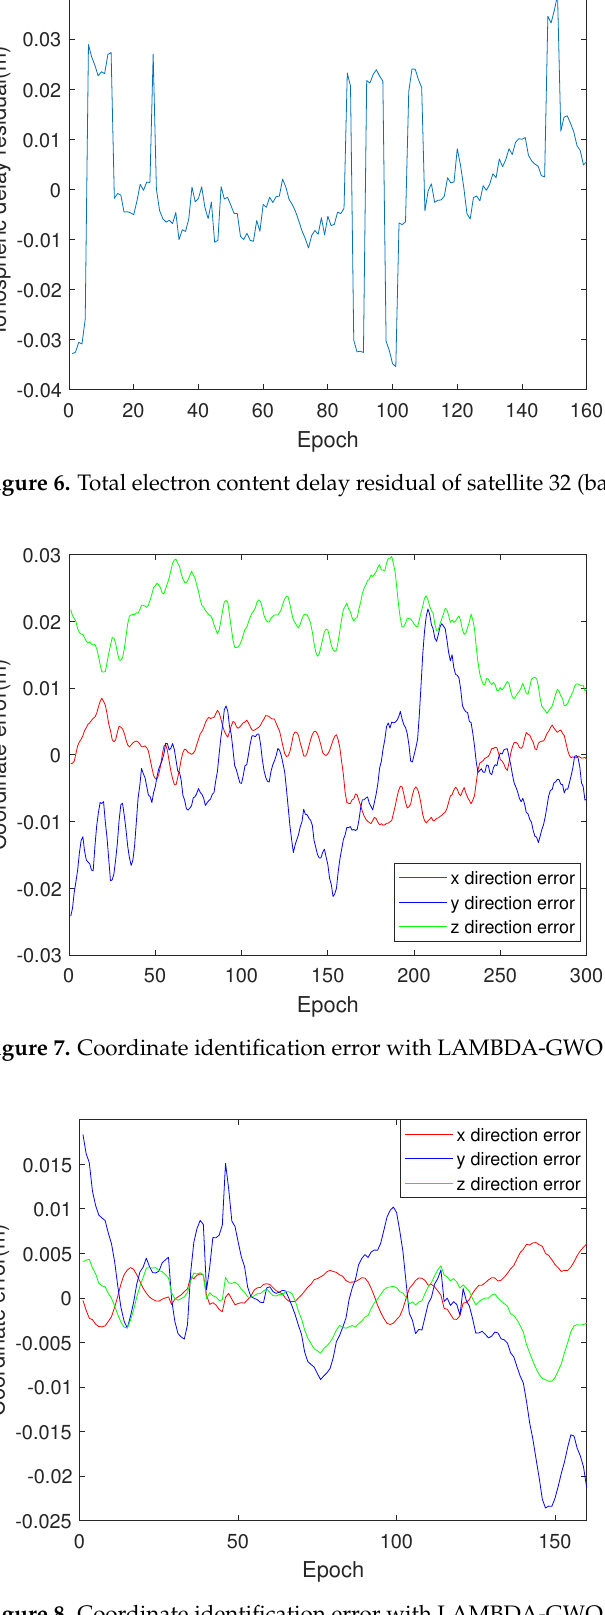
Figure 8. Coordinate identification error with LAMBDA-GWO (baseline